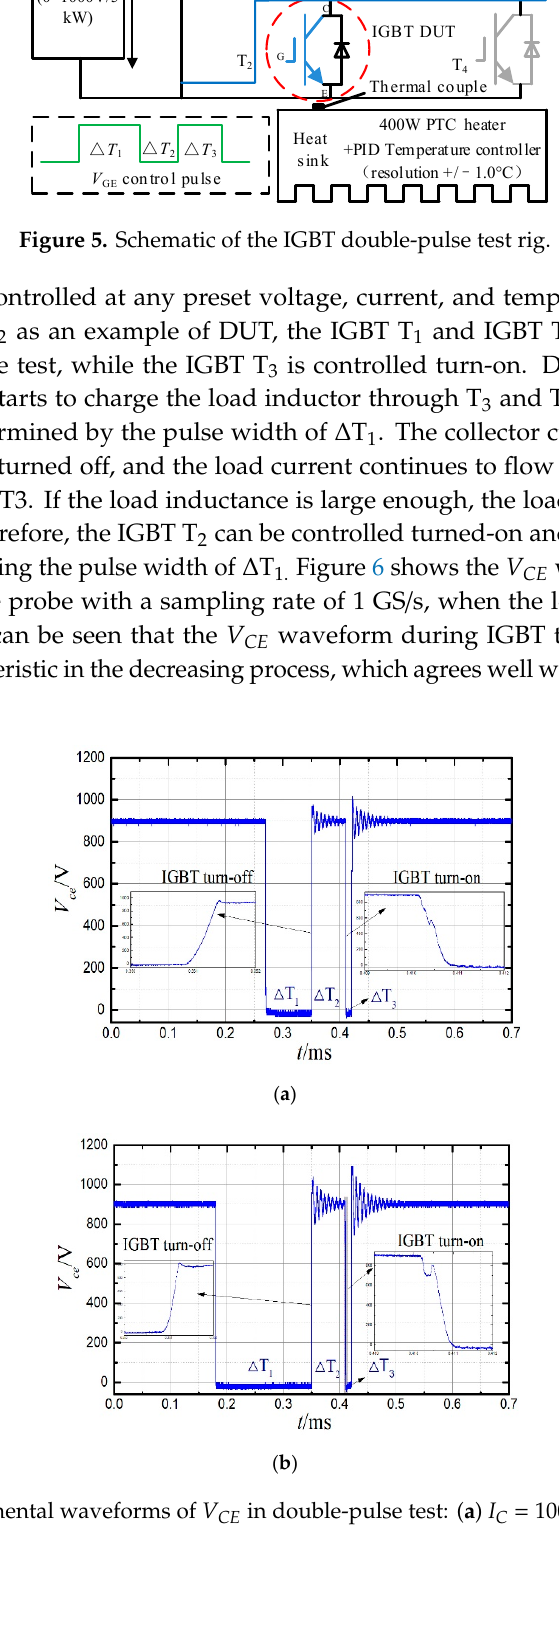
CE in double-pulse test: ( a ) I C